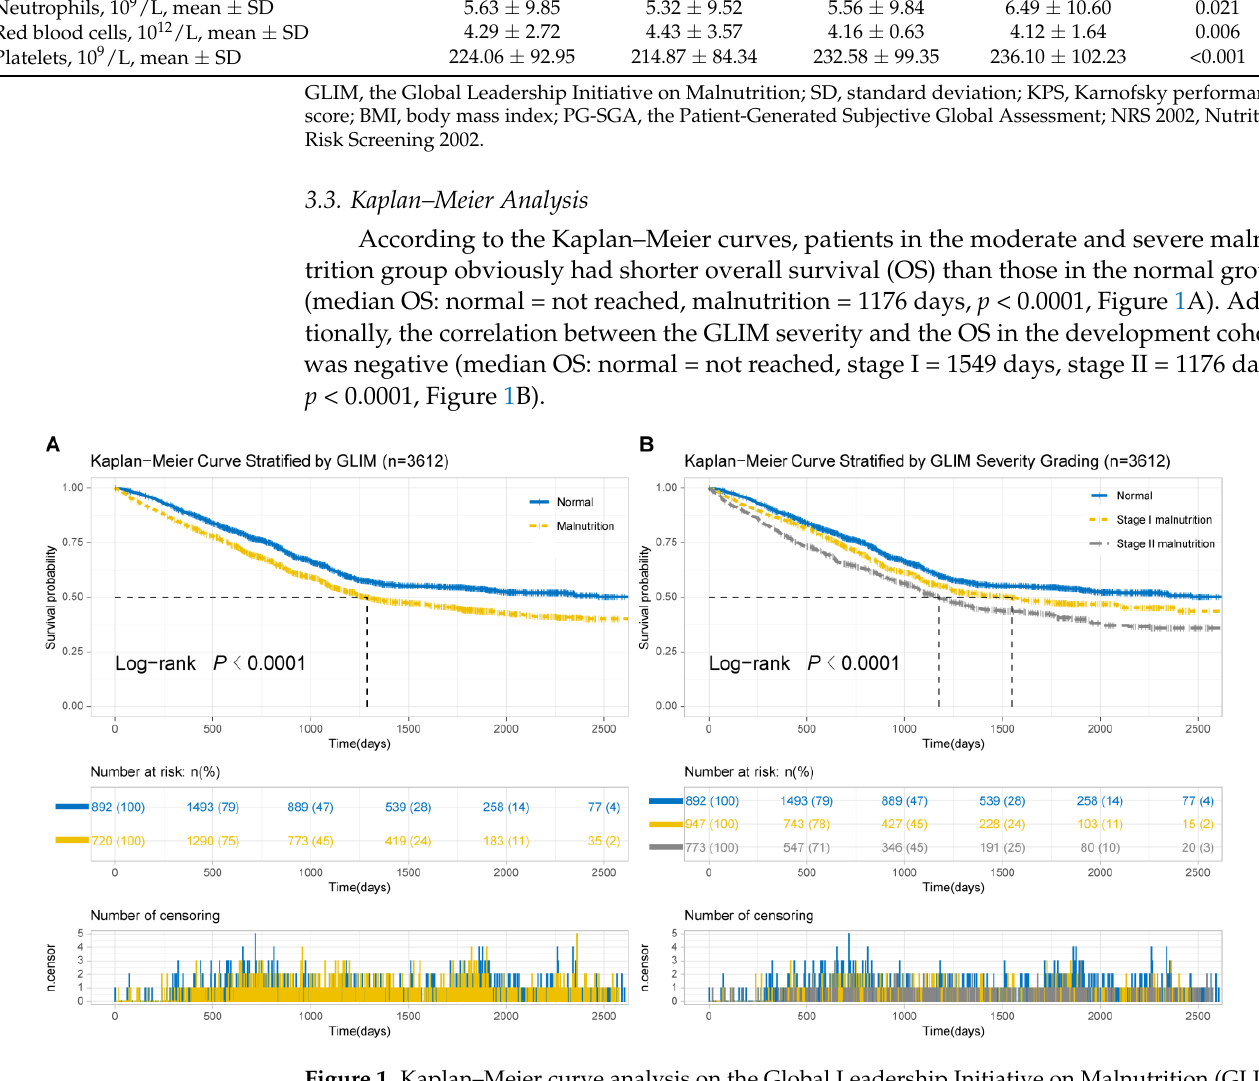
Figure 1. Kaplan–Meier curve analysis on the Global Leadership Initiative on Malnutrition (GLIM) grade. ( A ) Survival stratified by malnutrition. ( B ) Survival stratified by the severity of malnutrition. GLIM, the Global Leadership Initiative on